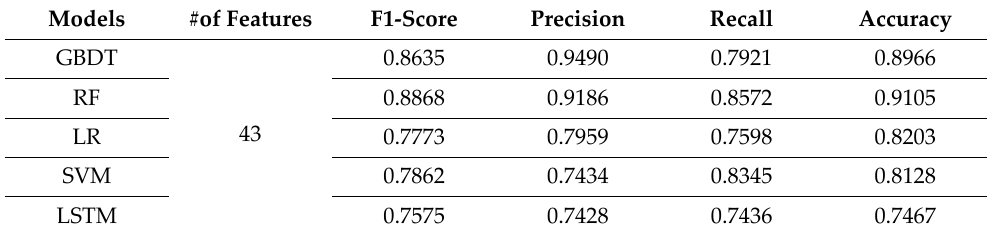
Table 2. Classifier performance when trained with the complete set of features.